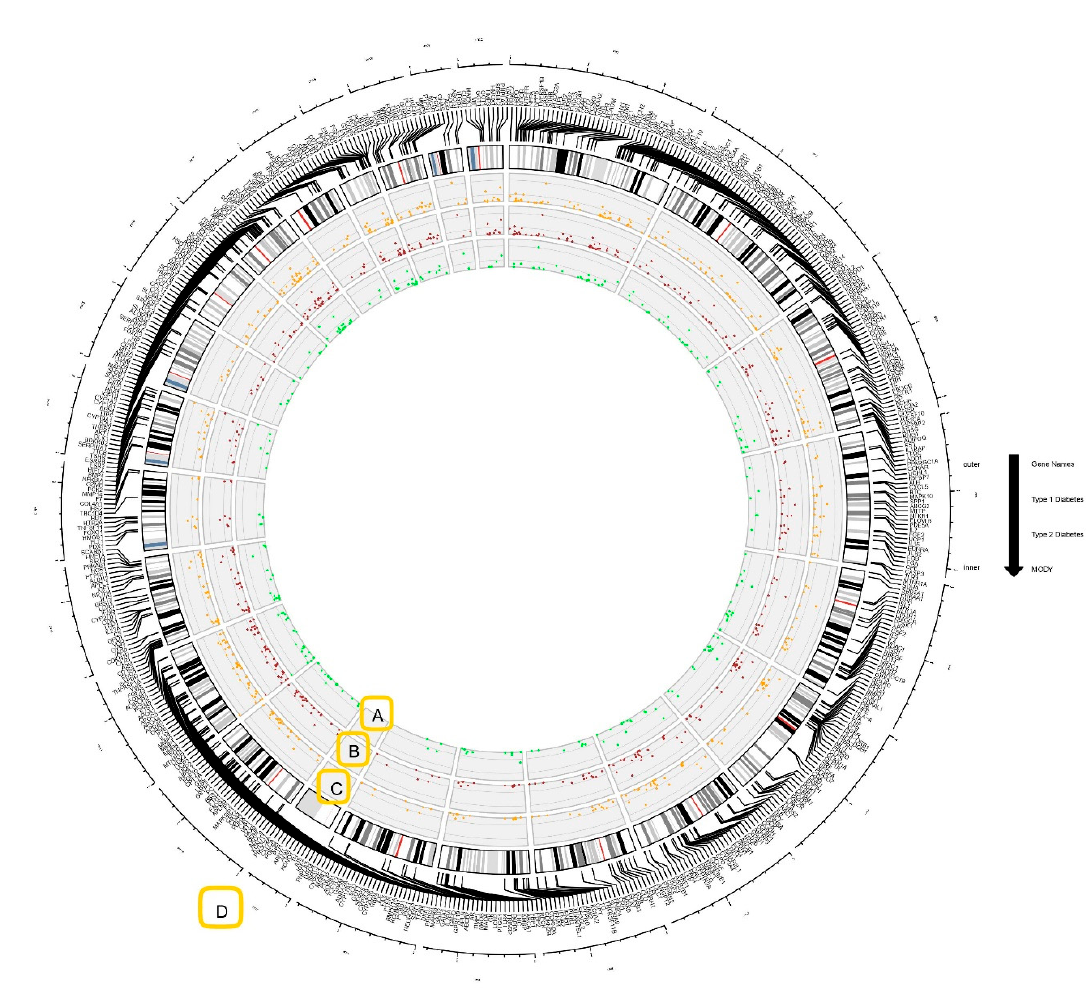
Figure 1. Circos plot demonstrating the genes associated with type-1 diabetes (T1D), type-2 diabetes (T2D), and maturity-onset diabetes of the young (MODY). The percentage of connectivity of genes in ( A ) MODY (green scatter points), ( B ) T2D (red scatter points), and ( C ) T1D (orange scatter points). ( D ) The group of genes from the same chromosome number are represented outside the Circos. The chromosome representation was provided by ideograms from a cytoband file format and imported to shinyCircos.